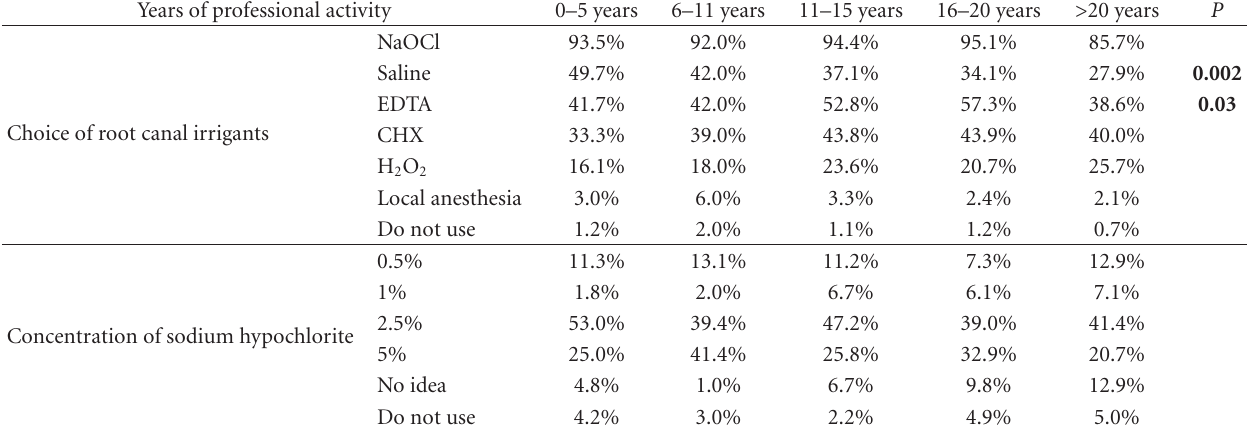
Table 4: Percentage of the preference of root canal irrigants and concentration of sodium hypochlorite according to years of professional